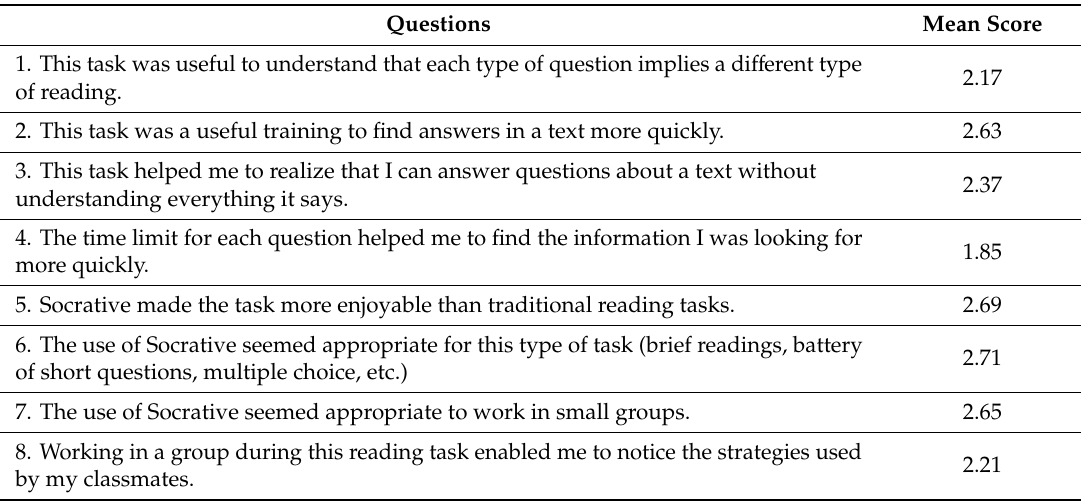
Table 2. Collaborative reading: questions and mean